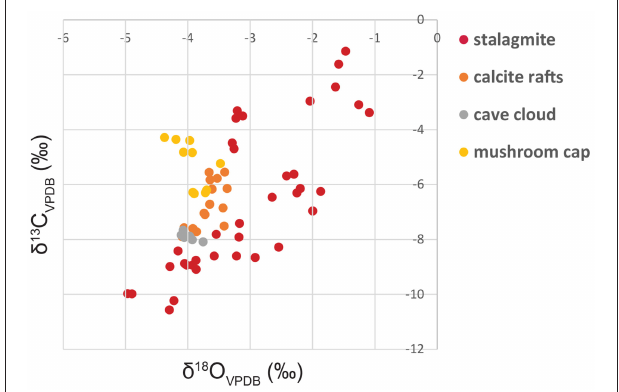
FIGURE 4 | δ 13 C and δ 18 O values measured from the different units of the mushroom speleothem. Analytical reproducibility of the measurements was better than ± 0.1 h ; for both δ 13 C and δ 18 O. Isotope ratios are measured against Vienna Pee Dee Belemnite (VPDB).